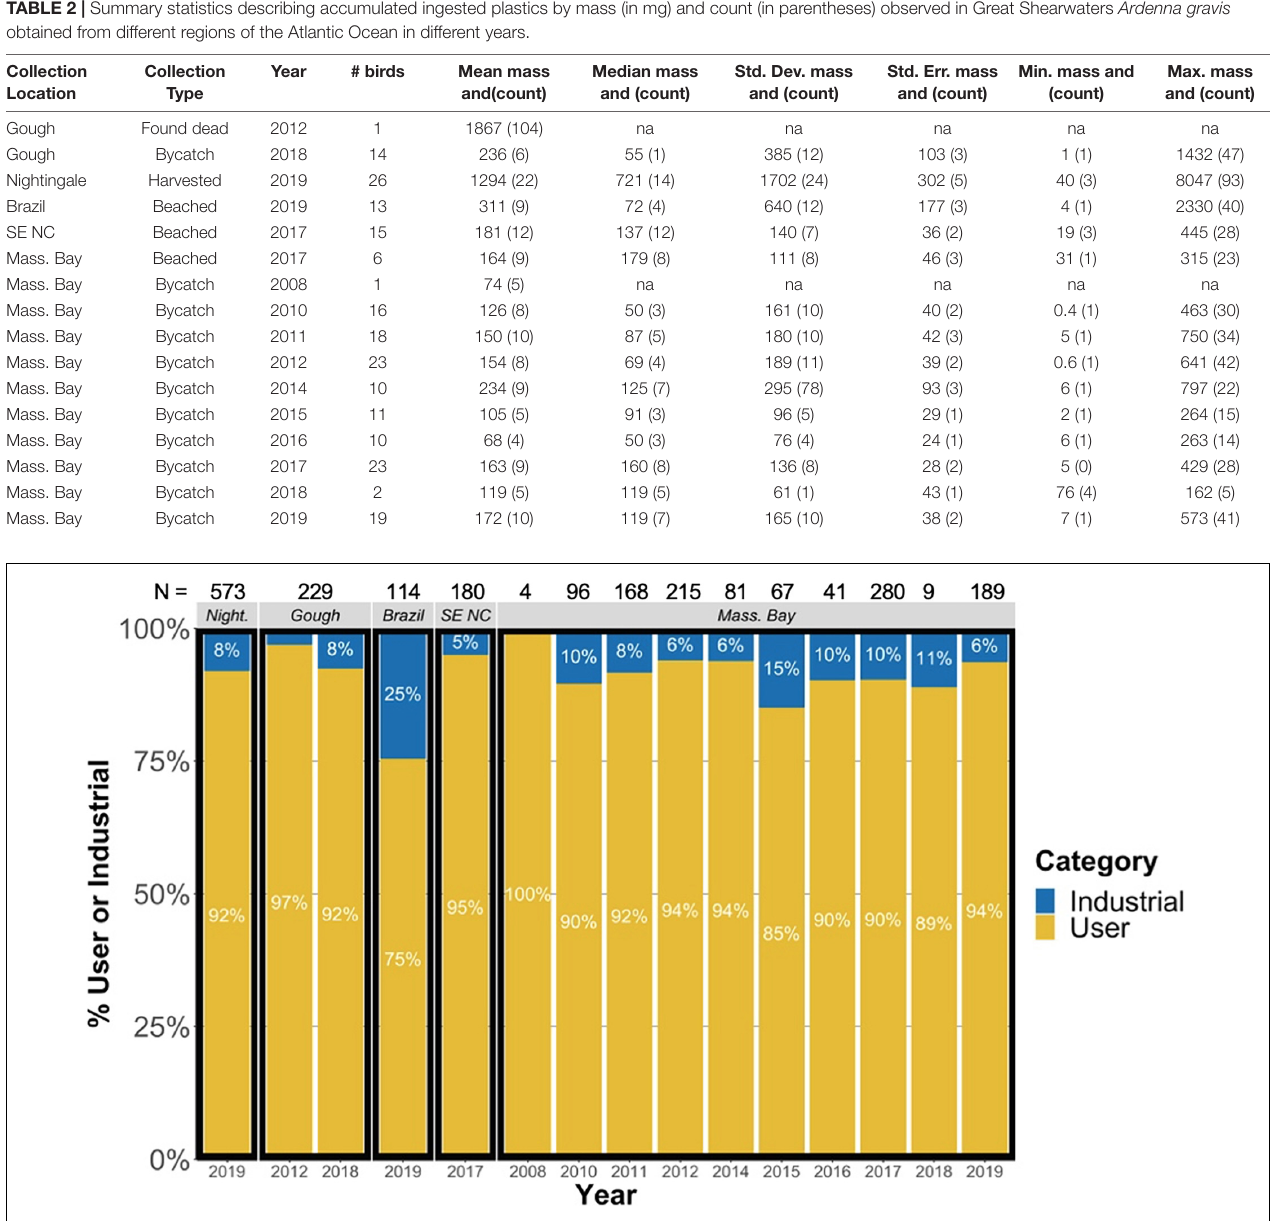
FIGURE 2 | Proportions of user and industrial plastic observed in gastrointestinal samples of Great Shearwaters Ardenna gravis from each location, and across multiple years in Massachusetts Bay. Night. = Nightingale Island; SE NC = Southeast North Carolina, United States; Mass. Bay = Massachusetts Bay, United States; N = number of plastic items